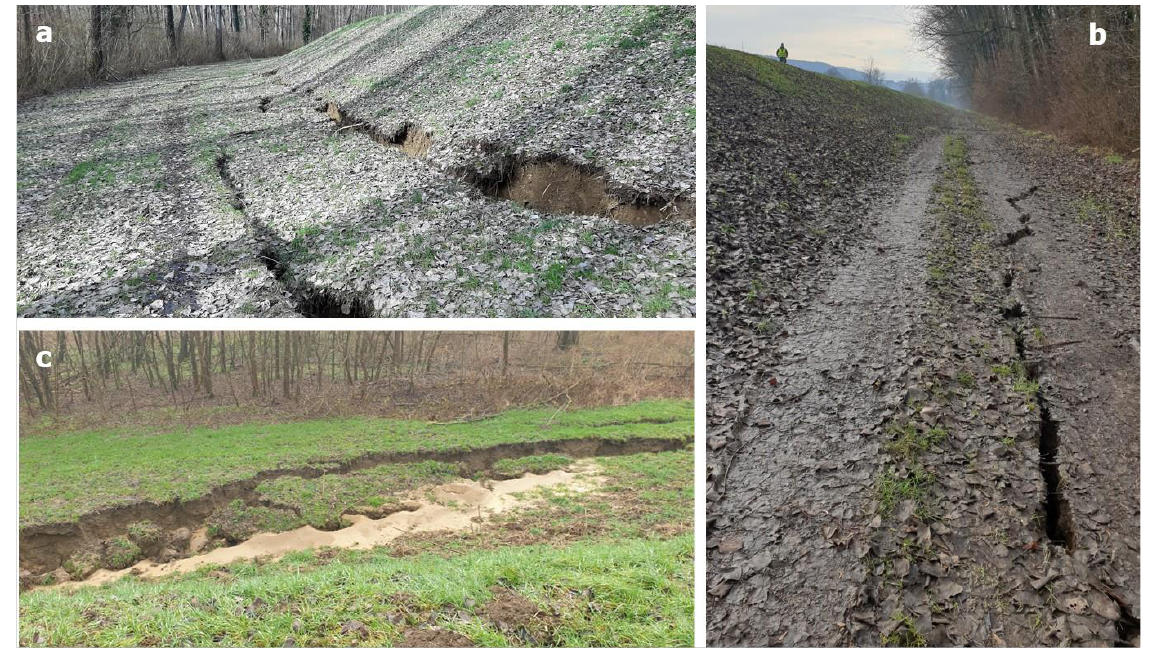
Figure 9. Typical damage to the embankment near Petrinja. There were numerous longitudinal cracks along the embankment, especially on the river side as in ( a , b ). On the opposite side, ejecta were found, as seen in ( c ). (Figure 9b,c are copied from [16]).